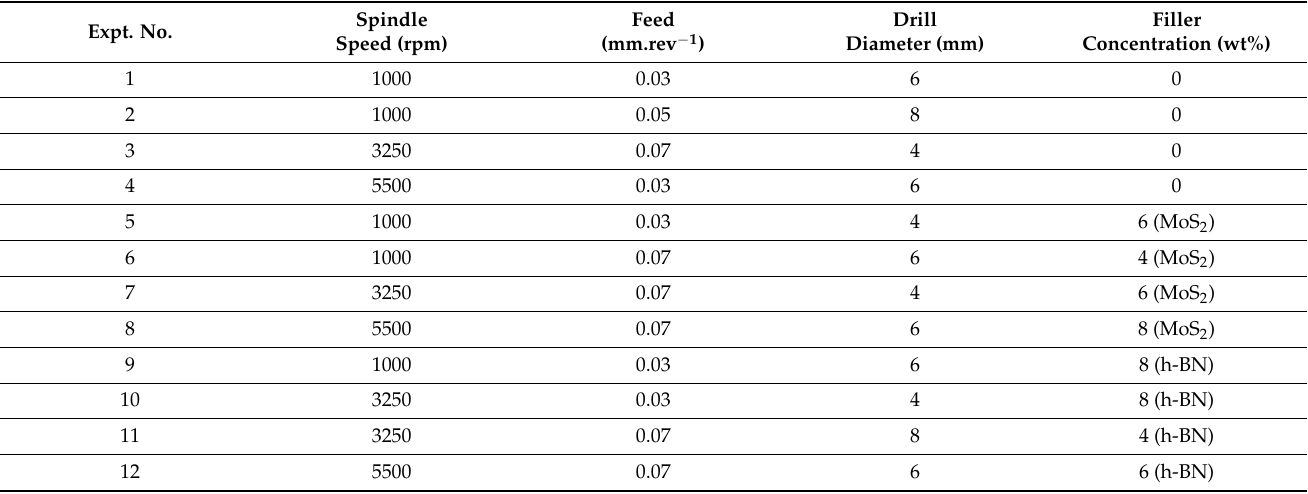
Figure 15. Thrust force contour plot of ( a ) MoS 2 -loaded CEC and ( b ) h-BN-loaded CEC. Figure 16. Thrust force contour plot of ( a ) MoS 2 -loaded CEC and ( b ) h-BN-loaded CEC. Table 19. The input conditions of validation